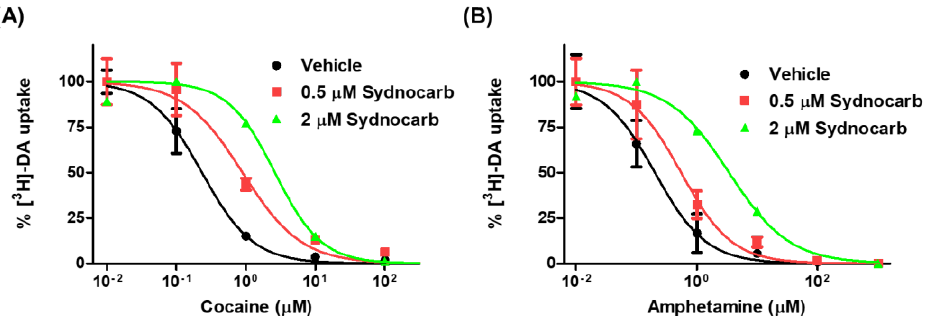
Figure 7. ( A ) Dopamine transport inhibition assay of cocaine in the absence and presence of 0.5 µ M and 2.0 µ M sydnocarb in hDAT-transfected COS-7 cells. IC 50 values of cocaine are 0.177 ± 0.034 µ M for the vehicle, 1.38 ± 0.24 µ M in the presence of 0.5 µ M sydnocarb (*), and 8.40 ± 0.99 µ M in the presence of 2.0 µ M sydnocarb (***). ( B ) Dopamine transport inhibition assay of amphetamine in the absence and presence of 0.5 µ M and 2.0 µ M sydnocarb in hDAT-transfected COS-7 cells. IC 50